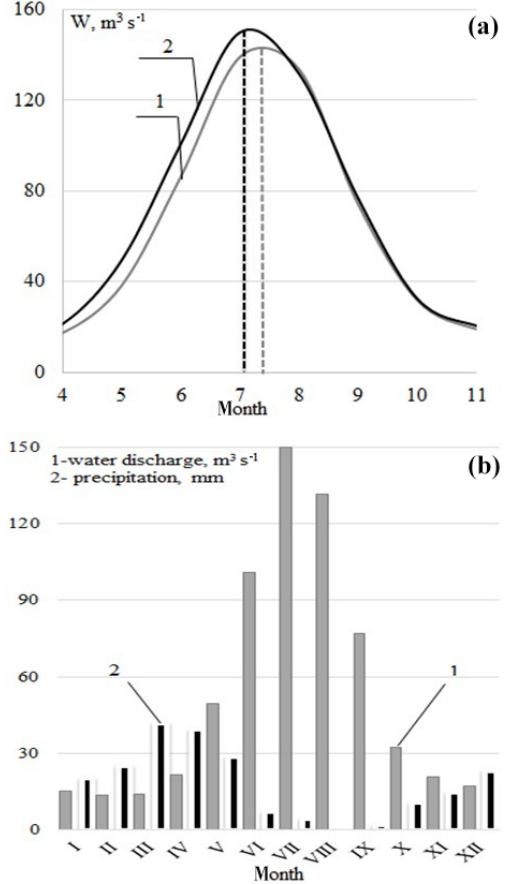
Figure 16. Hydrograph of the Vanch River for the period 1940– 1970 (1), 1986–2016 (2) (a) and the average monthly discharge val- ues of the Vanch River and atmospheric precipitation for the period 1940–2016 (b)